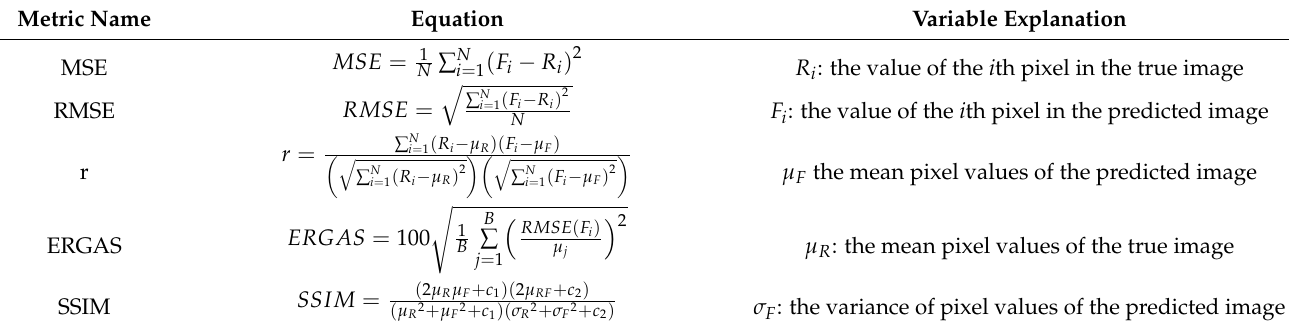
Table 3. Equations for accuracy metrics and the meaning of each